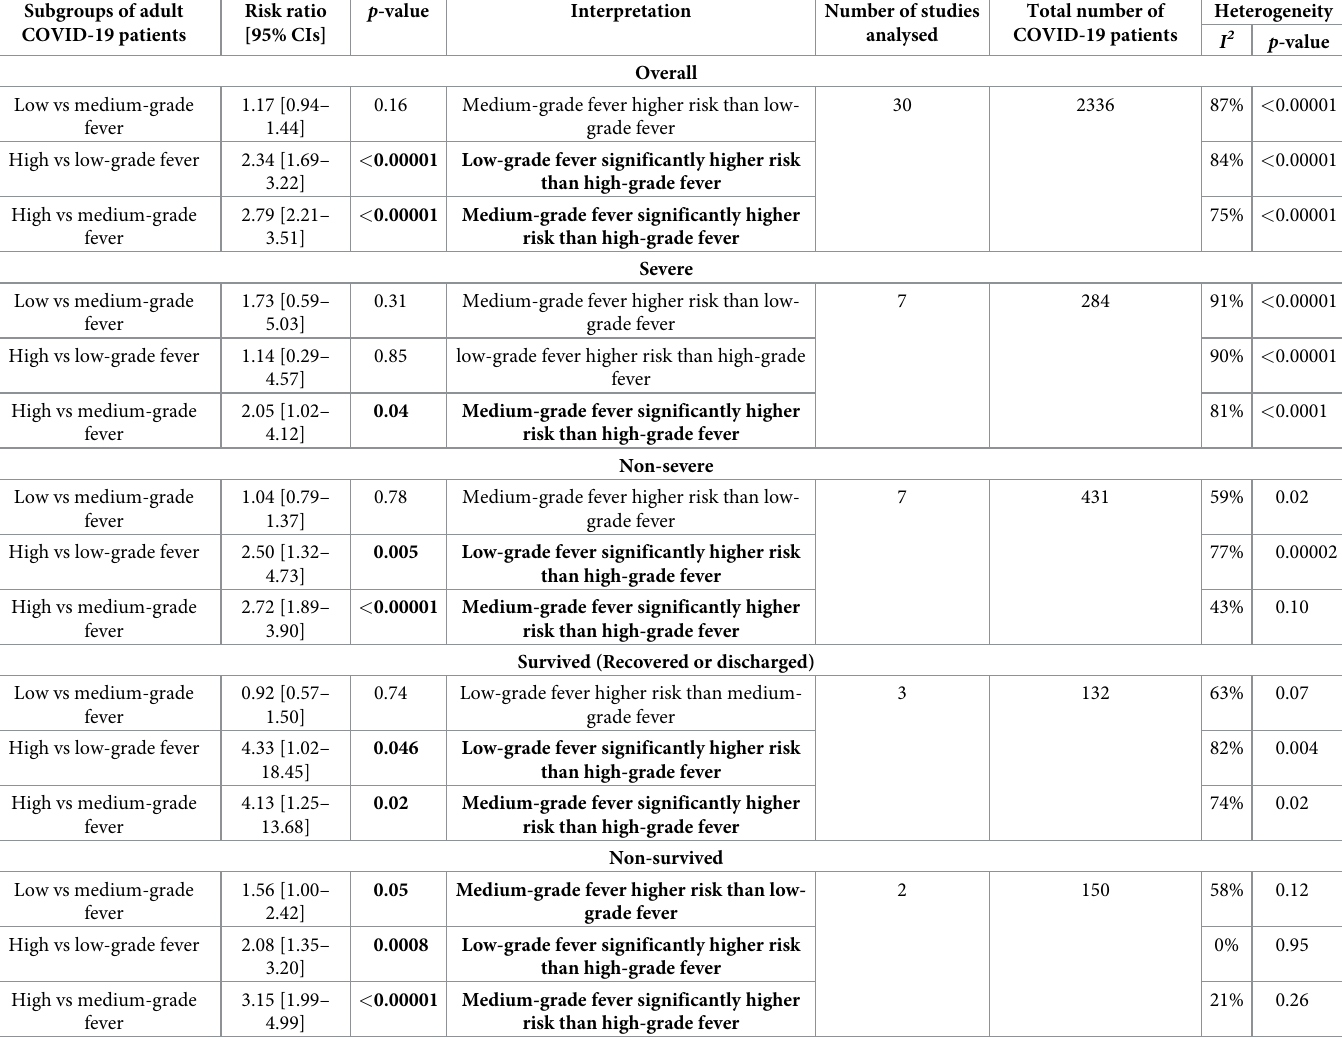
Table 3. Risk of different grades of fever in adult COVID-19 patients. Subgroups of adult COVID-19